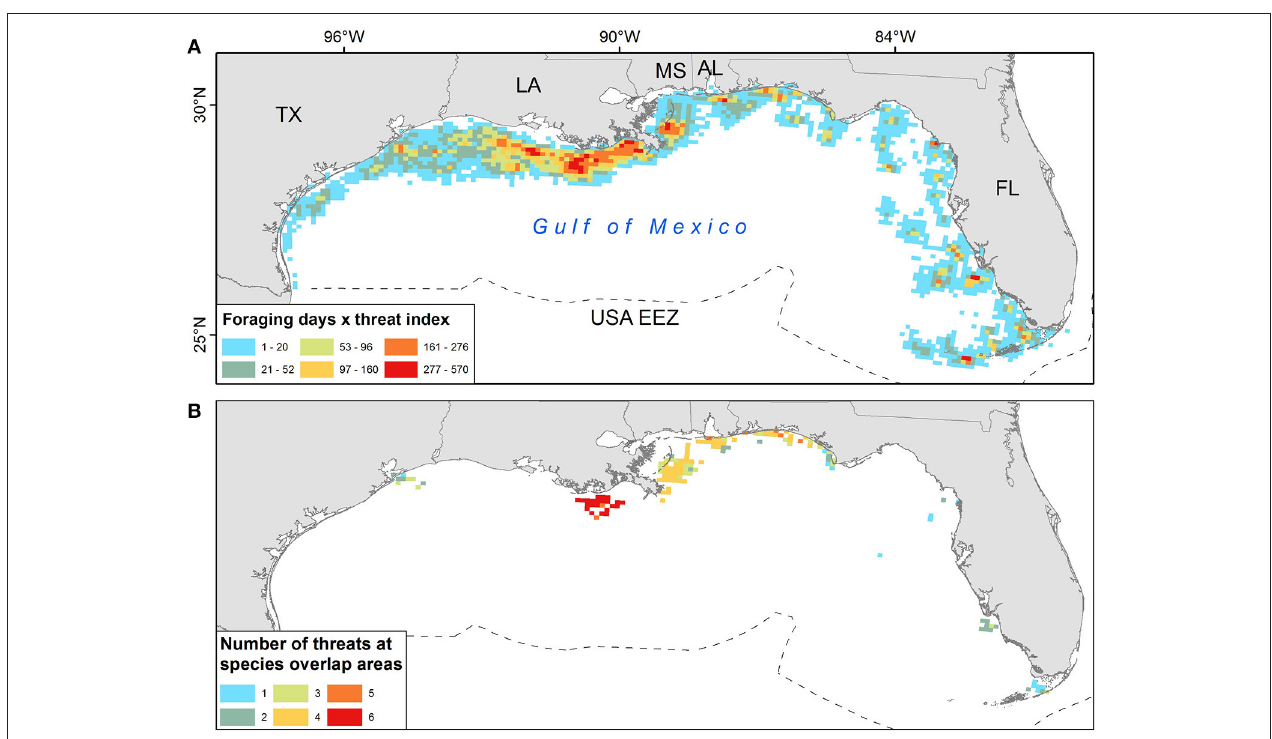
FIGURE 3 | (A) Foraging days for both Kemp’s ridley and loggerhead turtles multiplied by an anthropogenic threat index in 10km grid cells within the U.S. Exclusive Economic Zone (EEZ). “Hot spots” of turtle-use and anthropogenic threats are shown with red and orange cells (values 161- 570) (B) The number of threats in each grid cell for which foraging locations of both species were observed. “High” threats are shown by cells with 4–6 threats occurring (yellow, orange, red).